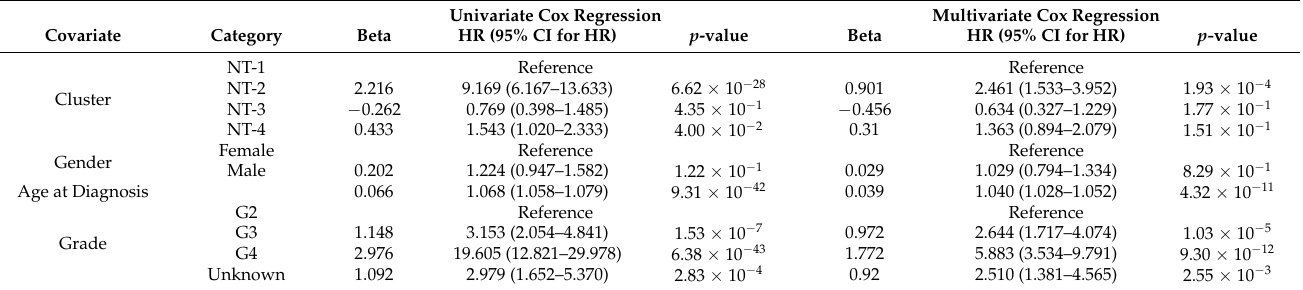
Table 2. Univariate and multivariate Cox regression analysis. Cluster (NT-1, NT-2, NT-3 and NT-4), gender (male and female), age at diagnosis and glioma grade (G1, G2, G3 and G4) information were integrated into this analysis as covariates. Univariate Cox Regression Multivariate Cox Regression